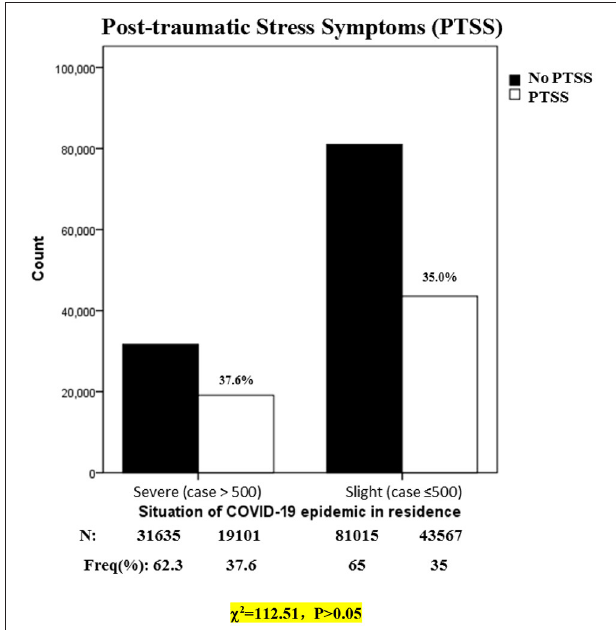
FIGURE 1 | Prevalence of PTSS during COVID-19 pandemic in China, stratified by situation of COVID-19 epidemic in residence ( N = 175,318). N, number; Freq,